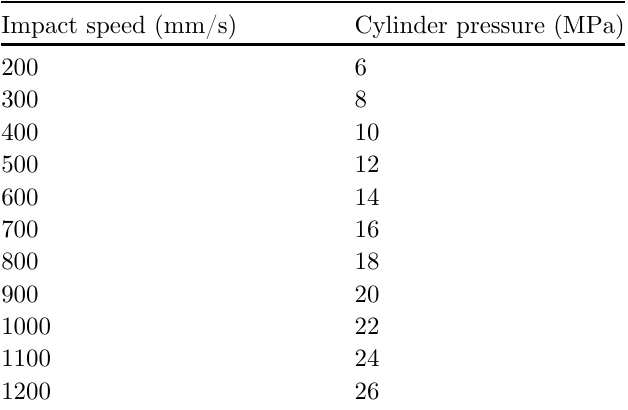
Table 4. Input data applied as part of the fi nite element